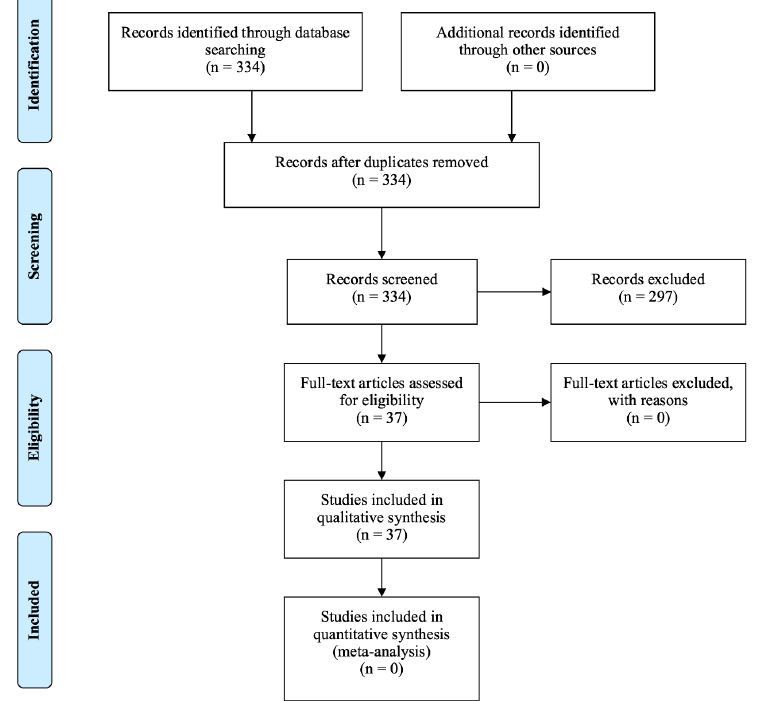
Figure 2. PRISMA flow diagram for the current literature review.